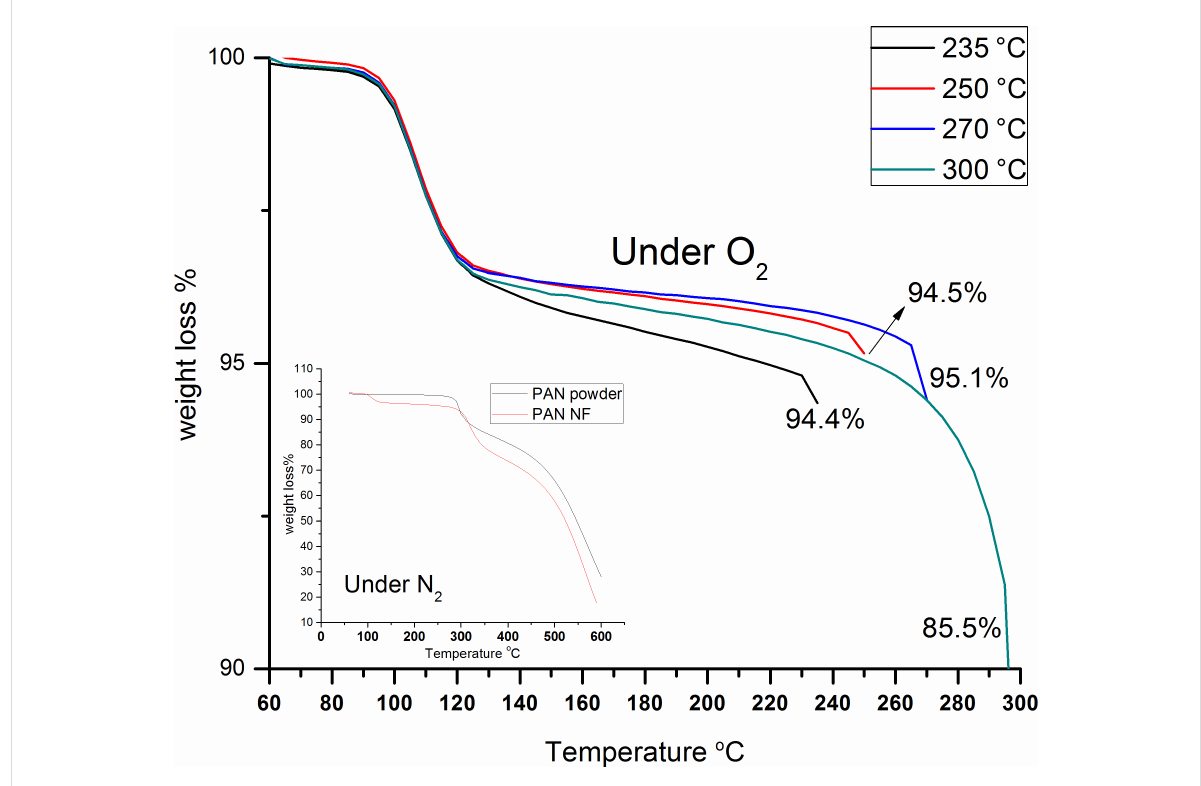
Figure 5: TGA curves representing the experimental conditions of oxidation for 300 min of different oxidation temperatures for webs of aligned PAN nanofibers (under air). The inset represents the TGA of PAN polymer under inert (nitrogen) atmosphere.